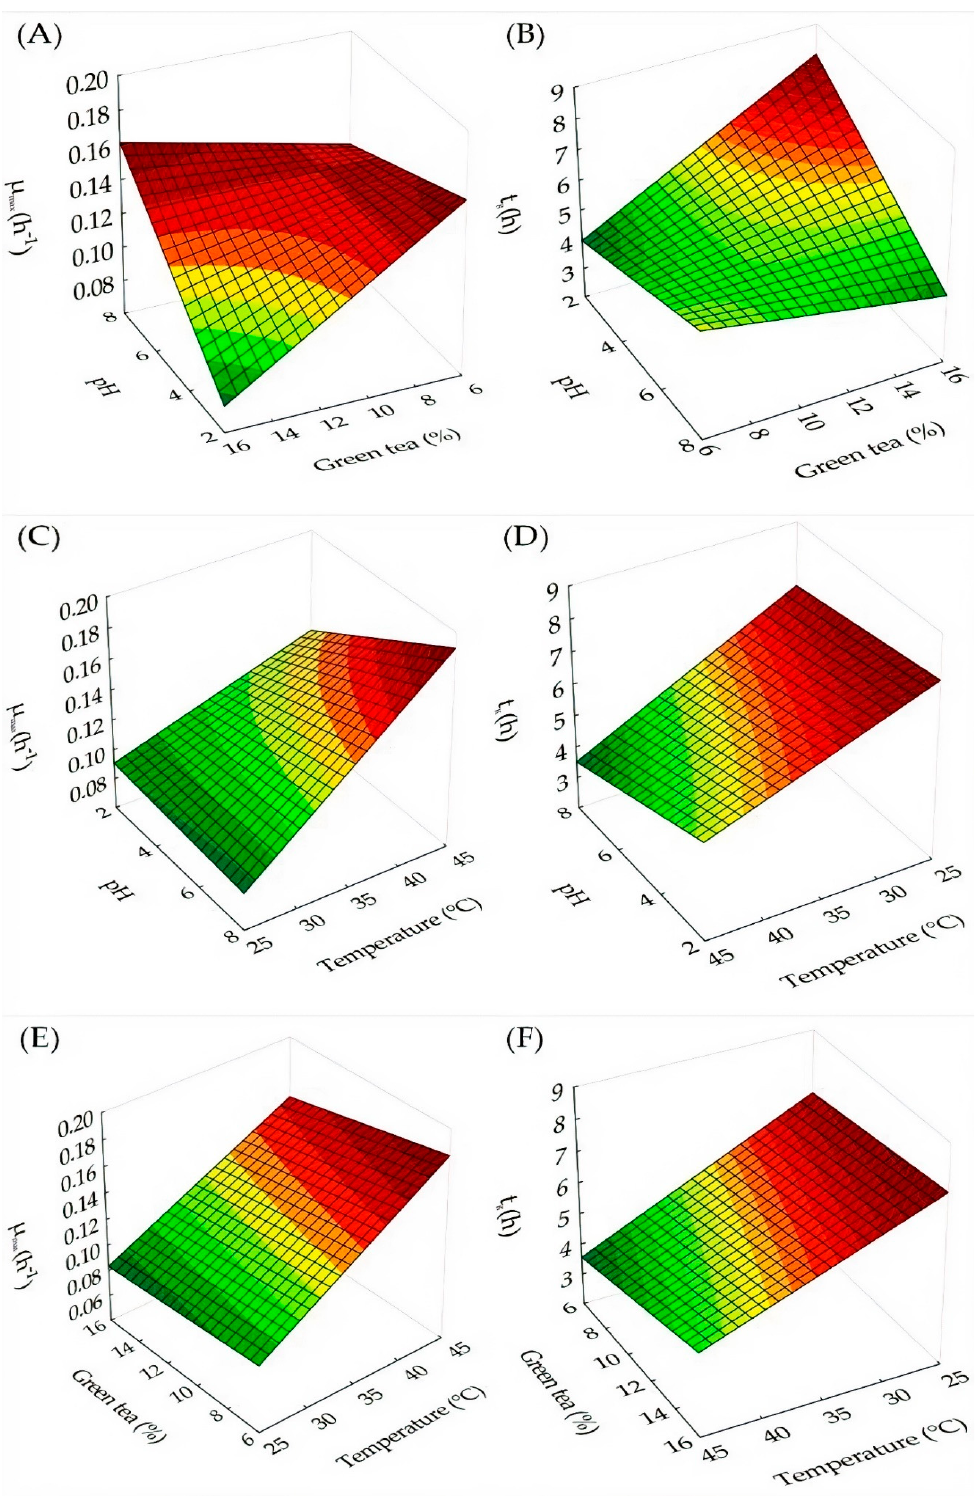
Figure 3. Effect of pH and green tea concentration on maximum growth rate ( A ) and generation time ( B ), pH and incubation temperature on maximum growth rate ( C ) and generation time ( D ), tea concentration green and incubation temperature on the maximum growth rate ( E ) and generation time ( F ) of L. gasseri in passion fruit